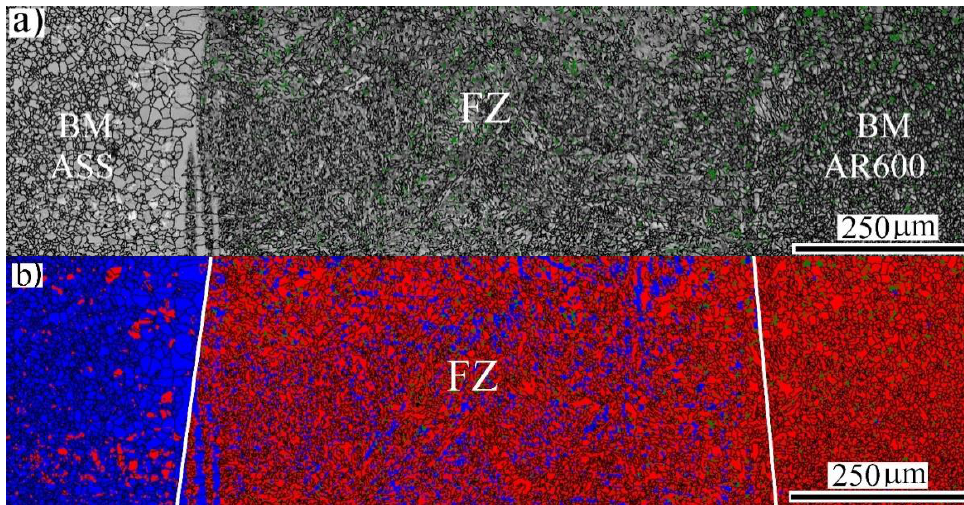
Figure 5. General view of the microstructure across the weld section of the dissimilar laser-welded butt joint at an EI of 160 J/mm: ( a ) EBSD IQ map; ( b ) EBSD phase map with indexing α - bct in red and γ - fcc austenite in blue.